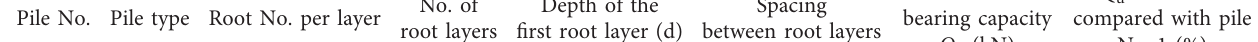
Table 2: Simulation programs and results of piles with different root arrangement. Pile No. Pile type Root No. per layer